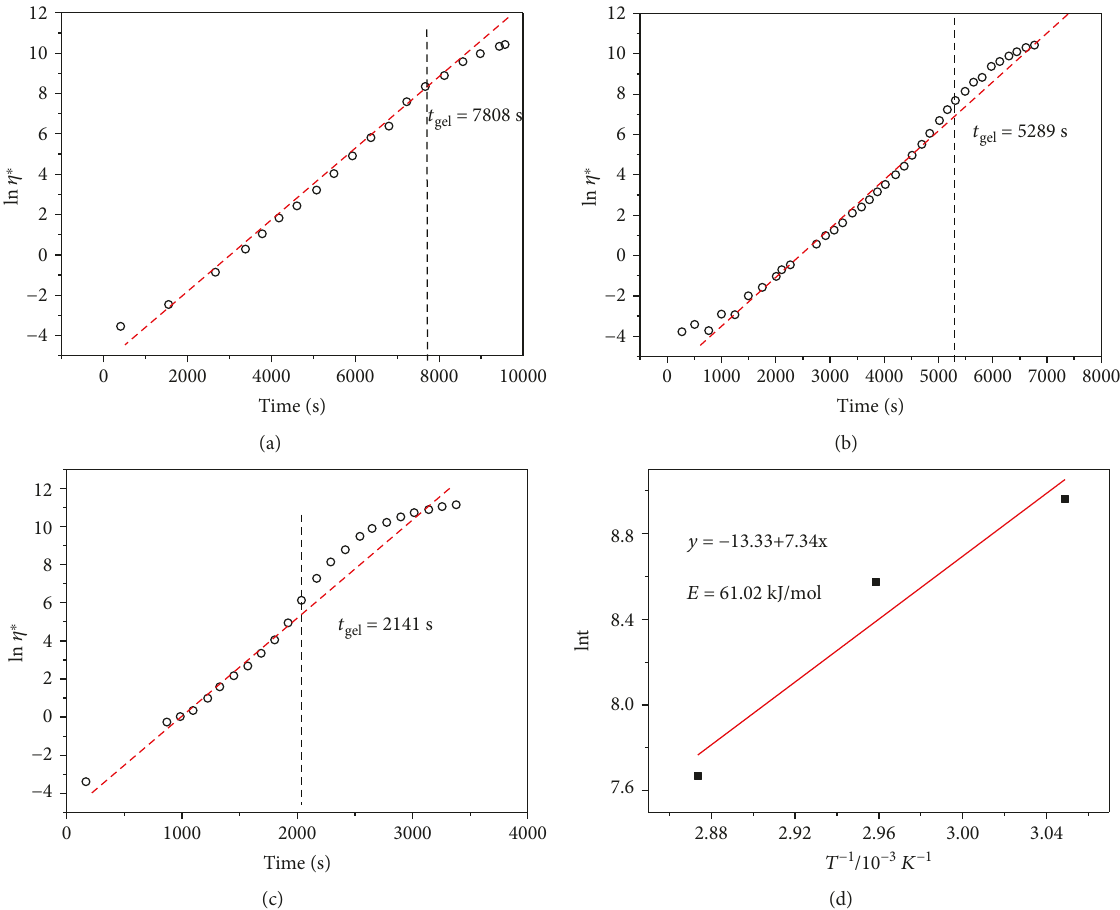
Figure 6: Plots of ln η ∗ vs. time for the polythiourethane system at (a) 55 ° C, (b) 65 ° C, and (c) 70 ° C. (d) Arrhenius plot of gel times for the polythiourethane